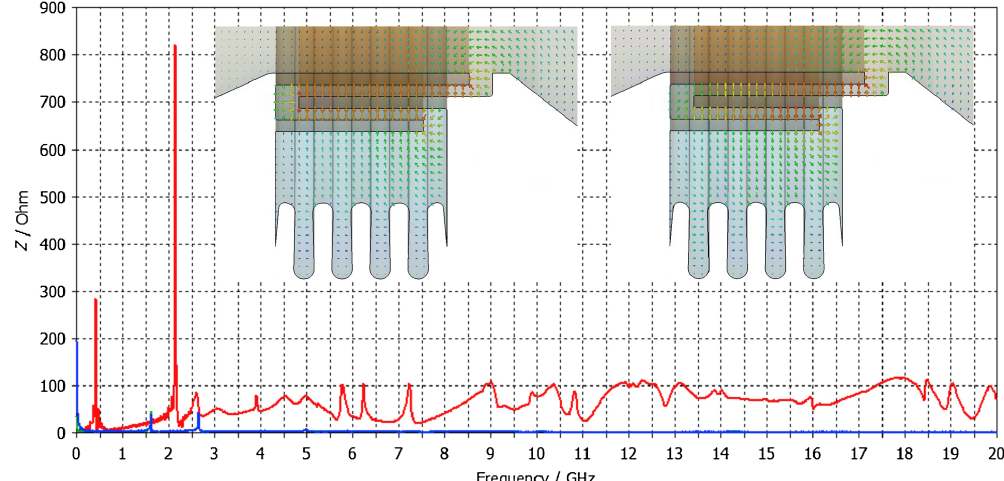
FIG. 3. Longitudinal beam impedance spectrum as simulated by the CSTS tudio© -wakefield solver. The most relevant peaks were detected at 423, 2150, and (less prominent) 3912 MHz (cf. Fig. 4). Their accuracy is limited to the width of one frequency sampling interval of 20.5 MHz. The insets show details of the eigenmode solver E-field distribution results of the two modes of lowest eigenfrequencies. These modes are found at 422 MHz (left, R=Q ¼ 15 . 8 Ω , no phase change along the labyrinth path) and 2155 MHz (right, R=Q ¼ 4 . 2 Ω , phase shift of π along the labyrinth